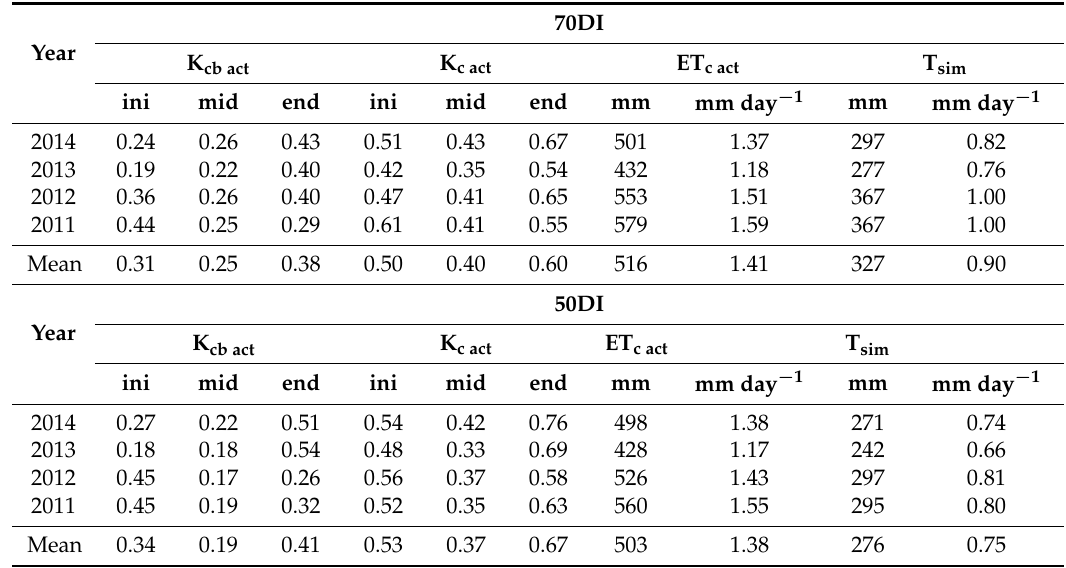
Table 5. Summary of the annual and mean ET c act and T sim obtained for 70DI and 50DI for all four years of the experiment, as well as the K cb act , K e , and K c act obtained for the initial, mid-, and end-seasons.